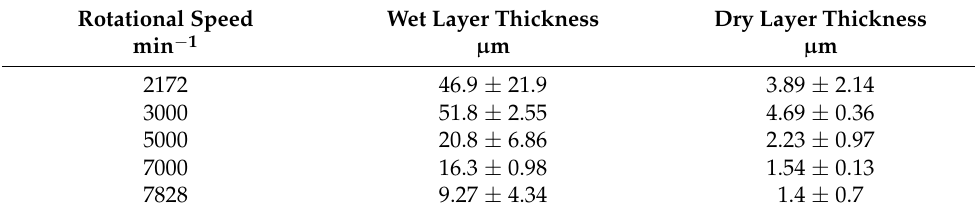
Table 4. Grammage and thickness of dry layers.